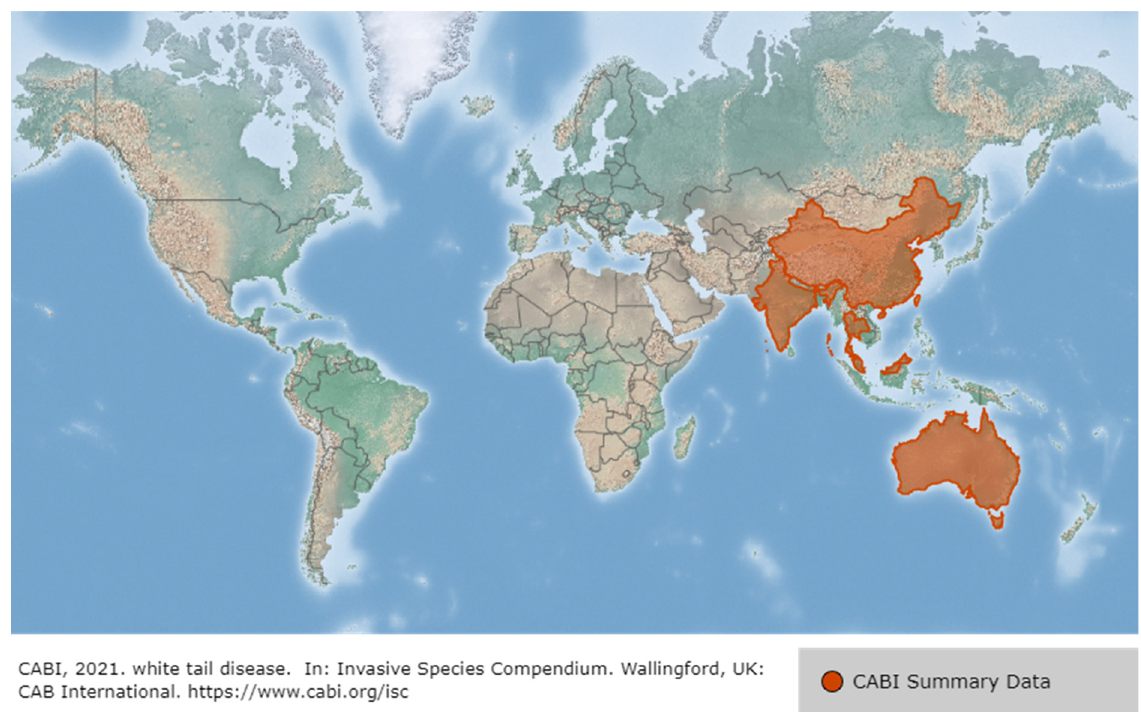
Figure 21. Distribution map of the geographical occurrence of White tail disease (WTD). (Reprinted from CABI, 2019, Macrobrachium rosenbergii nodavirus. In: Invasive Species Compendium. Wallingford, UK: CAB International, with permission from CABI).